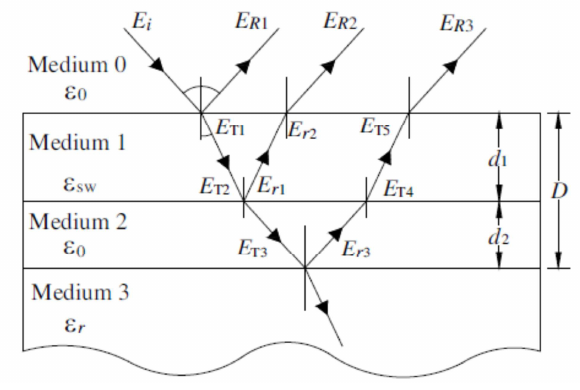
Figure 5. Multilayer reflection model soil